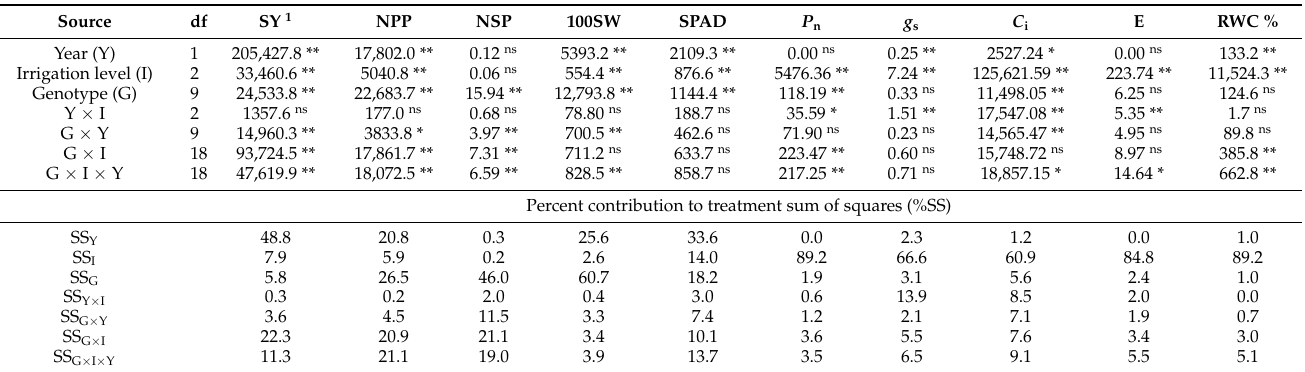
Table 1. Mean squares analysis of variance (ANOVA) and percentage (%) contribution regarding the treatment sum of squares (%SS) of the ten bean genotypes as affected by three irrigation levels over the two years (2014–2015).